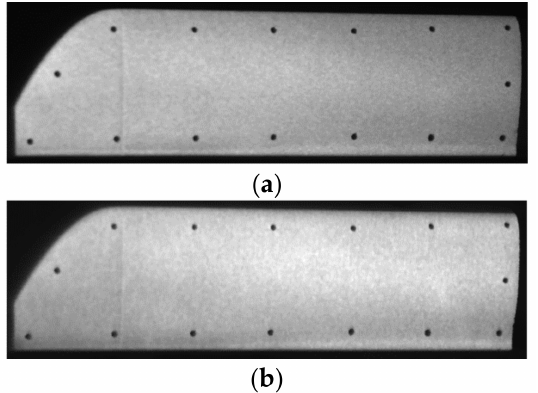
Figure 6. Comparison of PSP image in Gate 2. ( a ) I 2 under reference conditions. ( b ) I 2 at n = 840